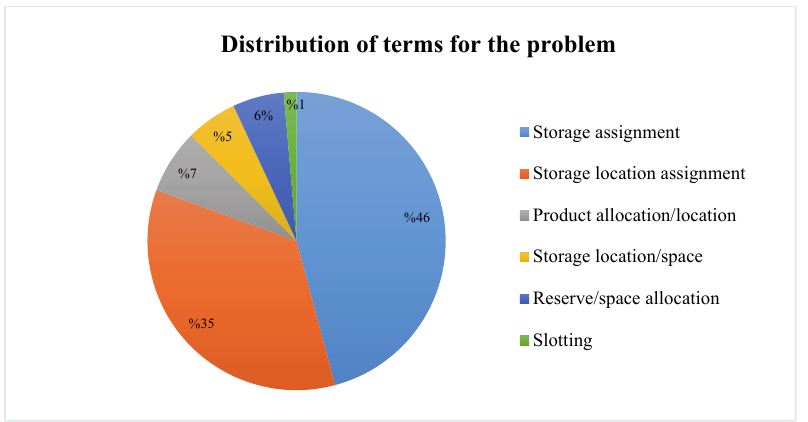
Fig. 5. Distribution of terms for the